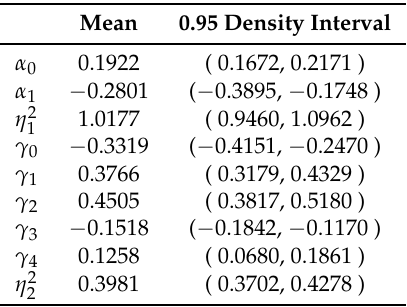
Table 2. Parametric model